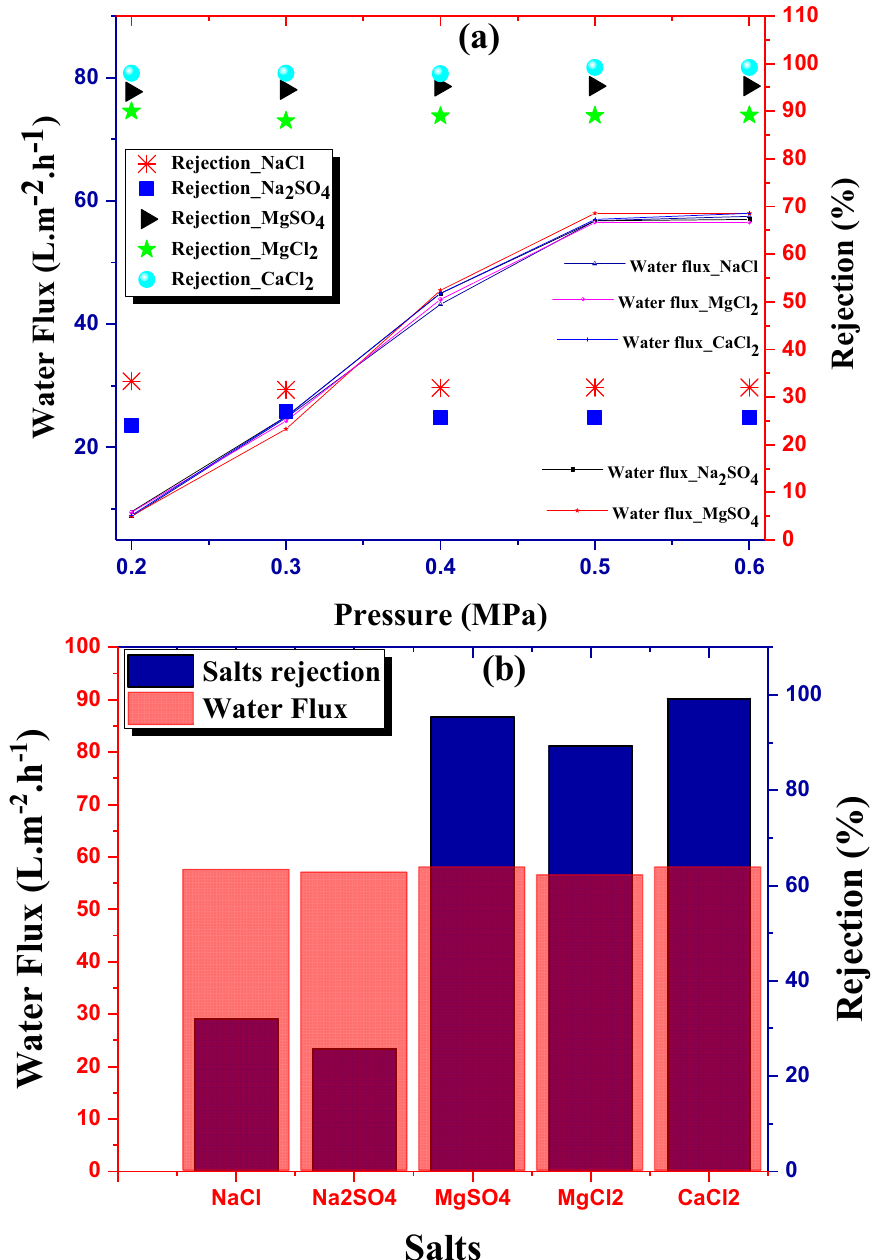
Figure 6. ( a ) Permeate flux and salts removal of NF_PAN_Ti as a function of transmembrane pressure and ( b ) water flux and salts rejection of NF_PAN_Ti under optimal conditions, [ Pressure ] = 0.6 MPa, [ Temperature ] = 25 ◦ C, [ Salts ] = 500 mg · L − 1 , pH = 10 ± Table 2. Membrane parameters used in this work.